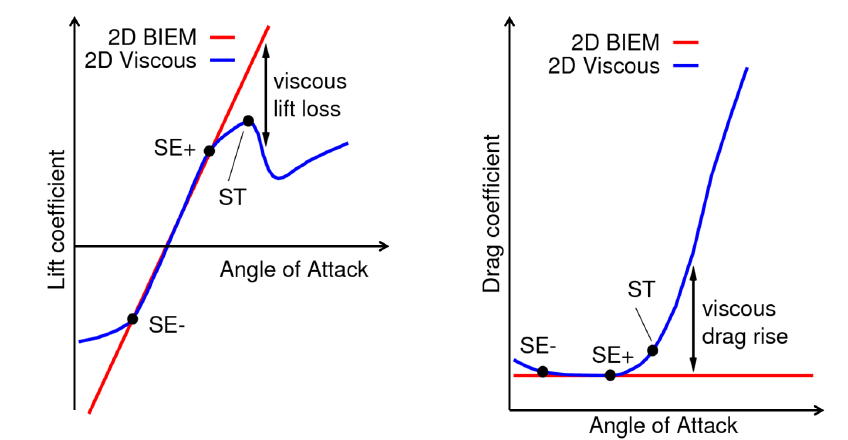
Figure 4. Notional lift and drag curves of a two-dimensional profile: viscous flow and inviscid flow conditions with flat plate drag correction